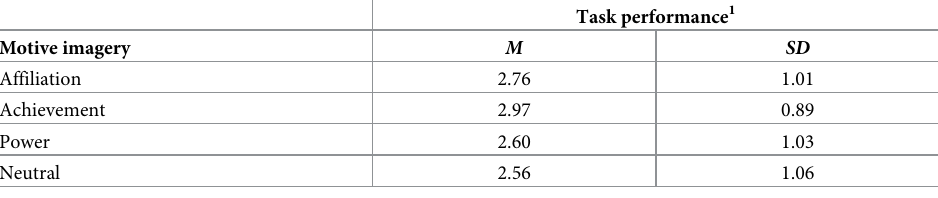
Table 7. Means and standard deviations for performance in neutral tasks and tasks related to affiliation, achieve- ment, and power (pooled data from Experiments 1, 2, and 3).